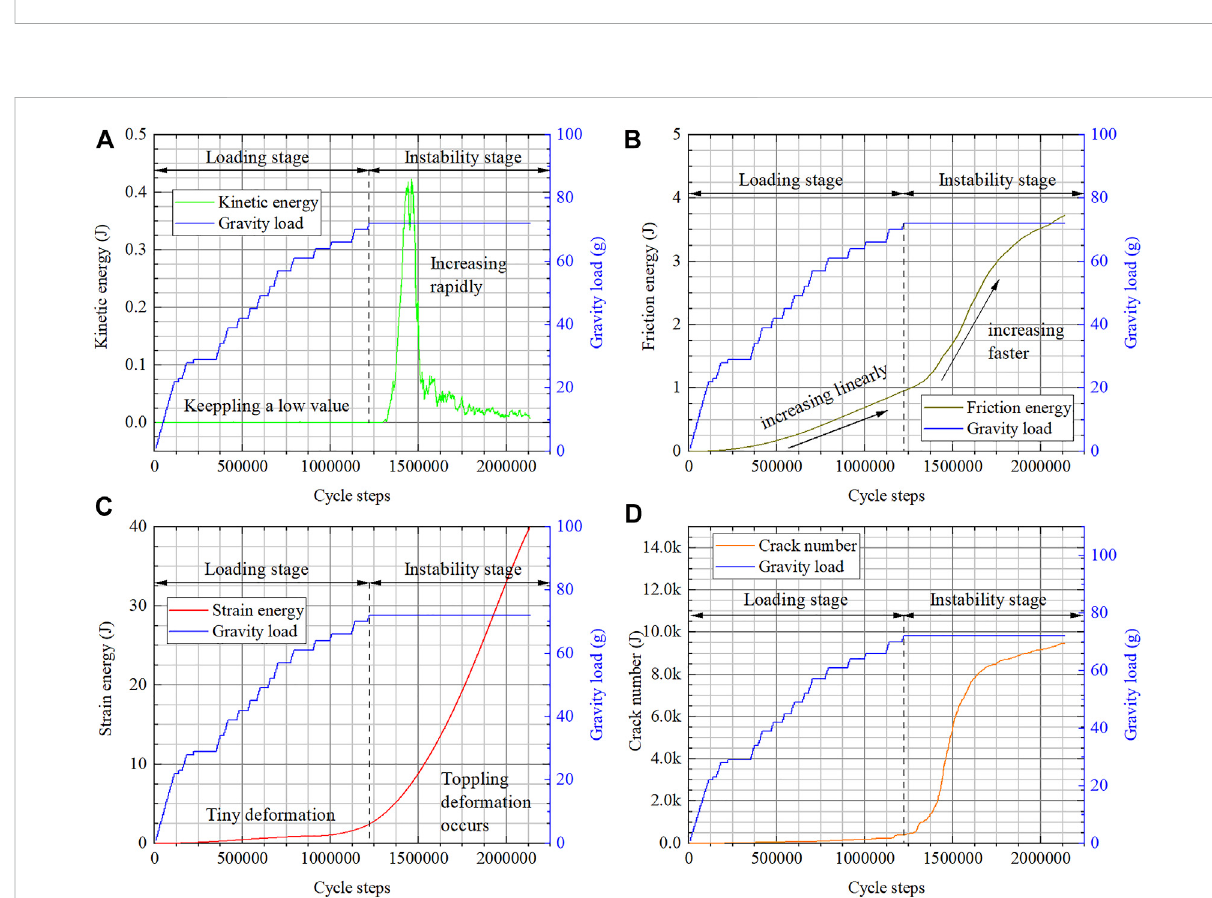
FIGURE 10 Energy evolution characteristics in the case of static